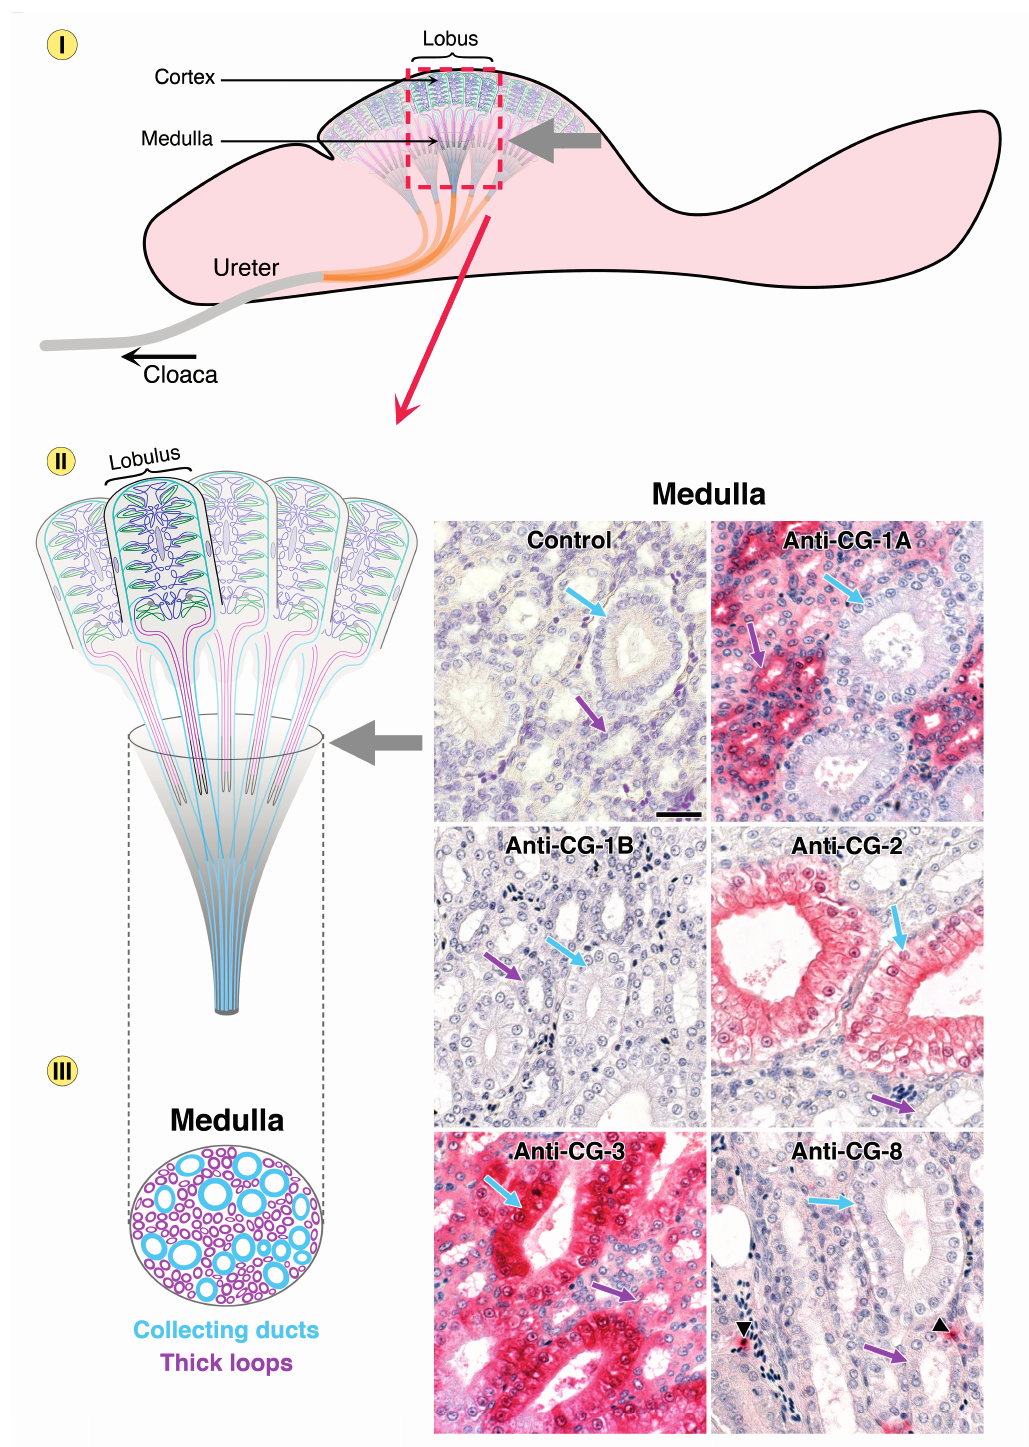
Figure 8. Schematic illustration of the chicken urinary system with focus on the medullary part of the kidney (top, grey arrow) with its collecting ducts and thick loops. Arrows in respective color point to these regions in the microphotographs (bar = 25 µm). Segmental specificity was revealed for CG-1A in epithelial lining of thick loops and CG-2 in collecting ducts, whereas no CG-1B could be detected and CG-8 positivity was exclusively seen in the connective